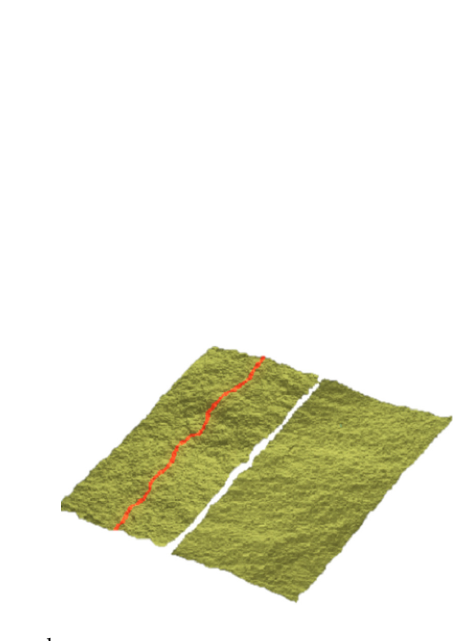
Figure 3. Visualized fracture surface of sandstone sample.